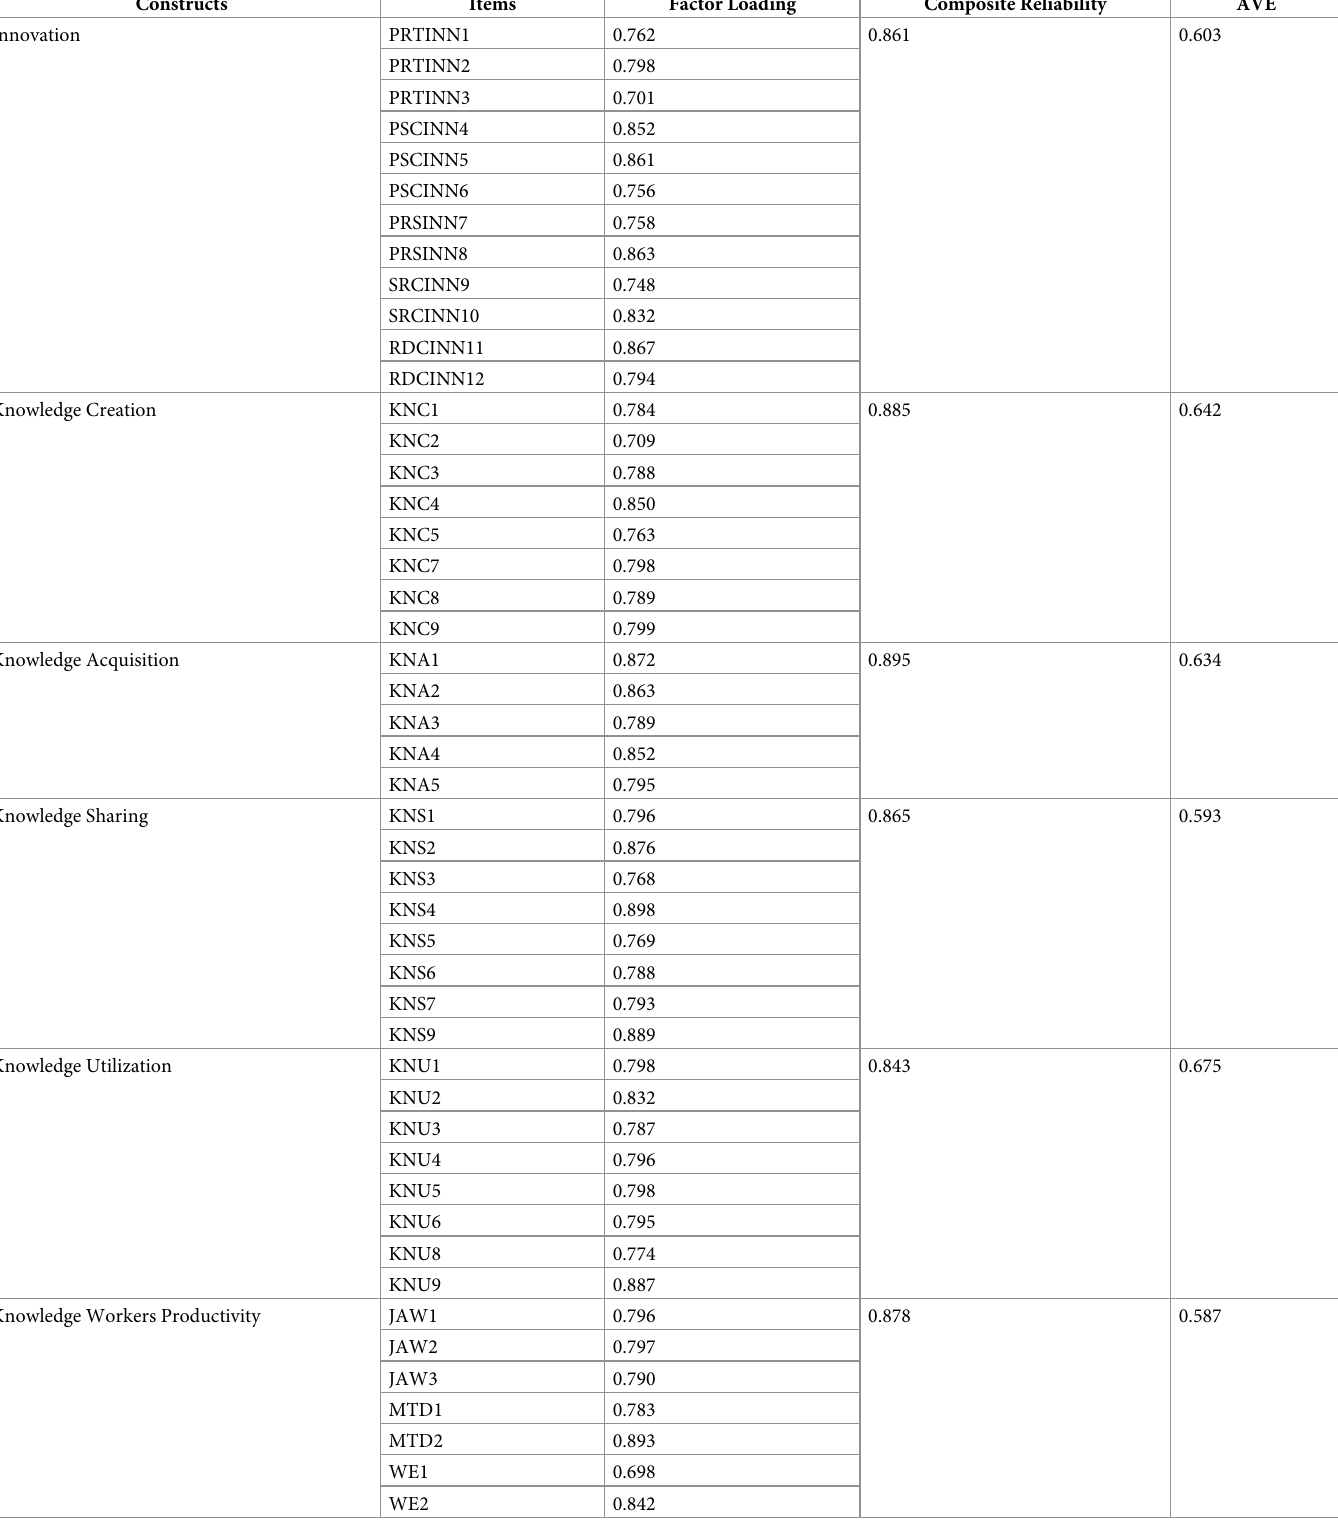
Table 2. Confirmatory factor analysis, composite reliability, and AVE